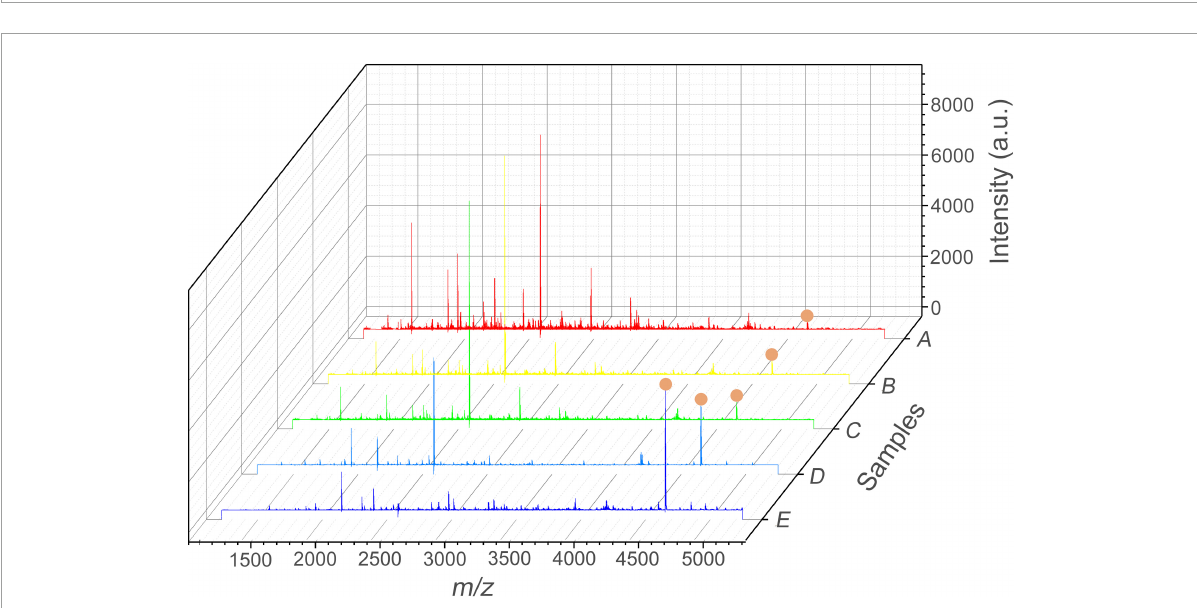
FIGURE4 SALDI MS spectra of A β 1 − 42 ([M + H] + , m/z = 4515.7) in the AD cell model. (A) Normal group without aptamer modification and any extraction step; (B) test group extracted with GO; (C) test group extracted with aptamer-modified GO non-covalently; (D) test group extracted with aptamer-modified GO covalently; (E) MS spectrum of A β 1 − 42 standard spiked in the human serum sample. Mass spectrometric peaks of A β 1 − 42 were labeled with red